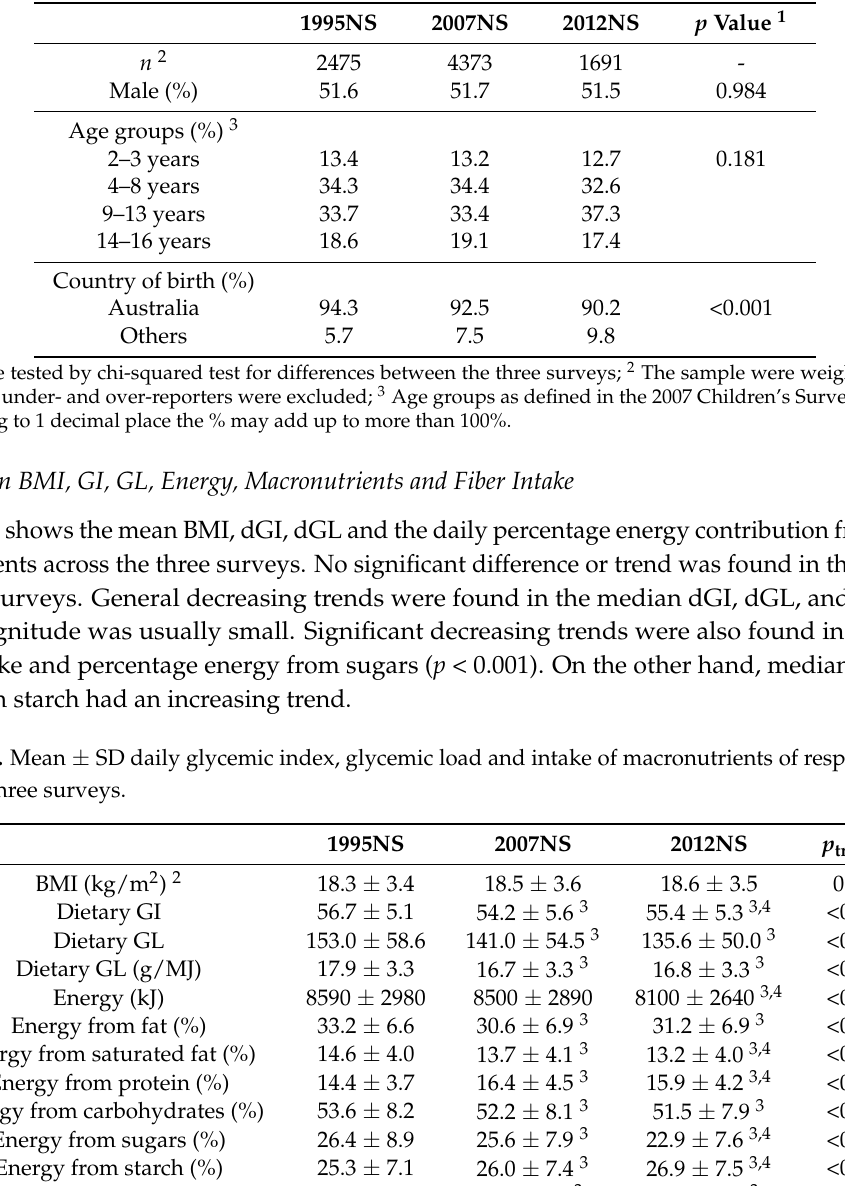
Table 1. Demographic characteristics of included participants.